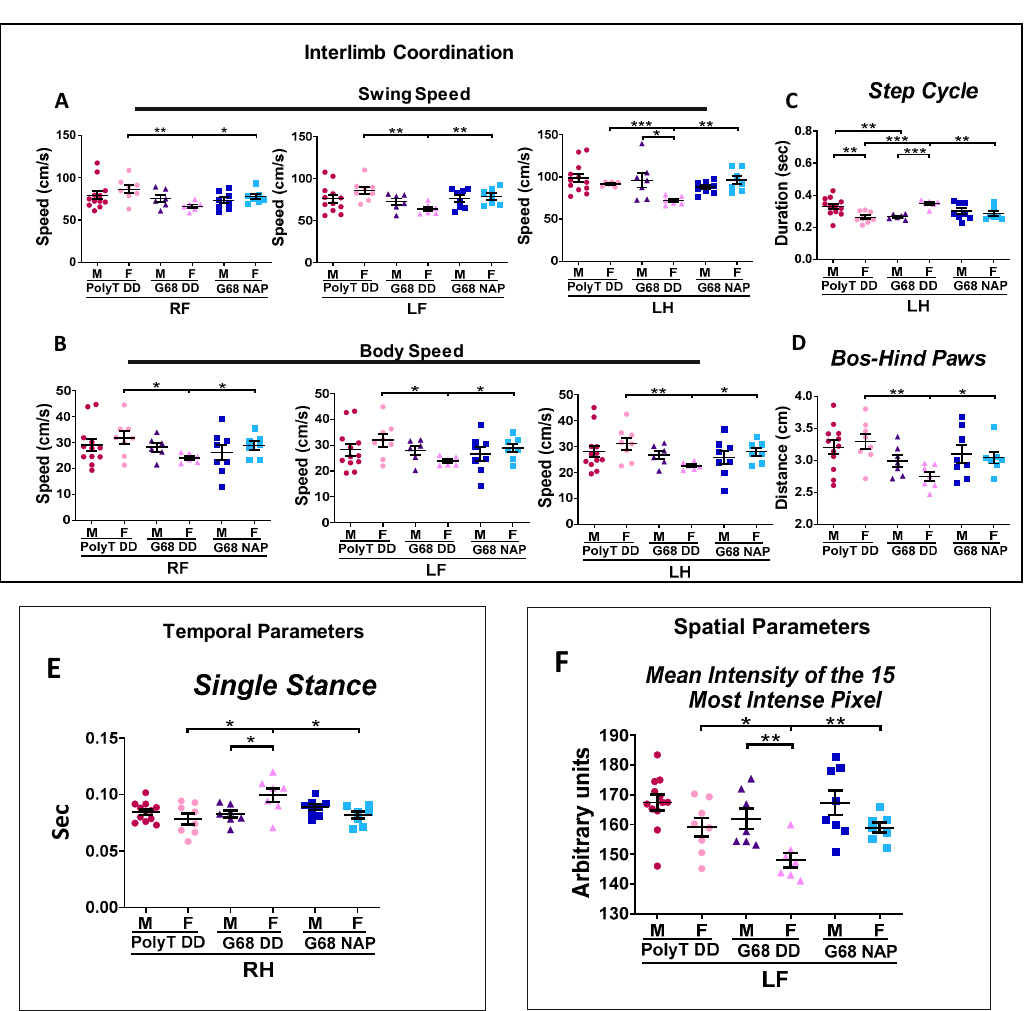
Figure 8. G68 female mice aberrant CatWalk behavior is ameliorated by NAP. CatWalk gait analysis: Poly T (males n = 12; females n = 8), G68 DD (males n = 7; females n = 7) and G68 NAP groups (males n = 8; females n = 7). ( A ) Swing Speed was significantly decreased in G68 female mice, compared with the Poly T DD group, and corrected by NAP treatment: RF (** p < 0.01, * p < 0.05, respectively); LF (** p < 0.01, ** p < 0.01, respectively); LH (*** p < 0.001, ** p < 0.01, respectively). Additionally, sex effect was observed in G68 DD group (* p < 0.05). ( B ) Body Speed was significantly decreased in G68 female mice, compared with the Poly T DD group, and corrected by NAP treatment: RF (* p < 0.05, * p < 0.05, respectively); LF (* p < 0.05, * p < 0.05, respectively); LH (** p < 0.01, * p < 0.05, respectively). ( C ) Step cycle an inverse impact was observed in males and females. In G68 DD males, the duration of the step cycle was significantly shorter (** p < 0.01), compared with the Poly T DD male group, whereas G68 DD females displayed a significantly longer step cycle, compared with the Poly T DD female group (*** p < 0.001), normalized by NAP treatment (** p < 0.01). Also, sex differences were found in Poly T DD (** p < 0.01) and G68 DD groups (*** p < 0.001). ( D ) Base of support (BOS) was significantly smaller in G68 DD female mice, compared with Poly T DD female mice (** p < 0.01) and NAP-treated G68 female mice (* p < 0.05). ( E ) Single stance was significantly longer in G68 DD female mice, compared with the Poly T DD (* p < 0.05) and NAP-treated G68 female mice (* p < 0.05). Additionally, sex di ff erences were observed in the G68 DD group (* p < 0.05). ( F ) The Mean Intensity of the 15 Most Intense Pixel was significantly decreased in the G68 DD, compared with the Poly T DD female mice (* p < 0.05), and NAP-treated G68 female mice (** p < 0.01). Sex di ff erences were observed in the G68 DD group (** p < 0.01).